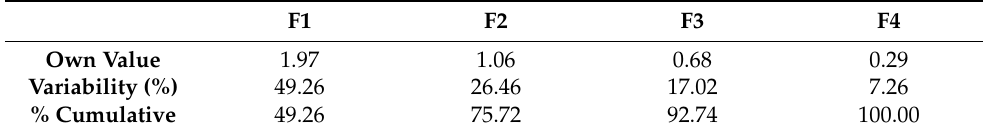
Table 2. Eigenvalue